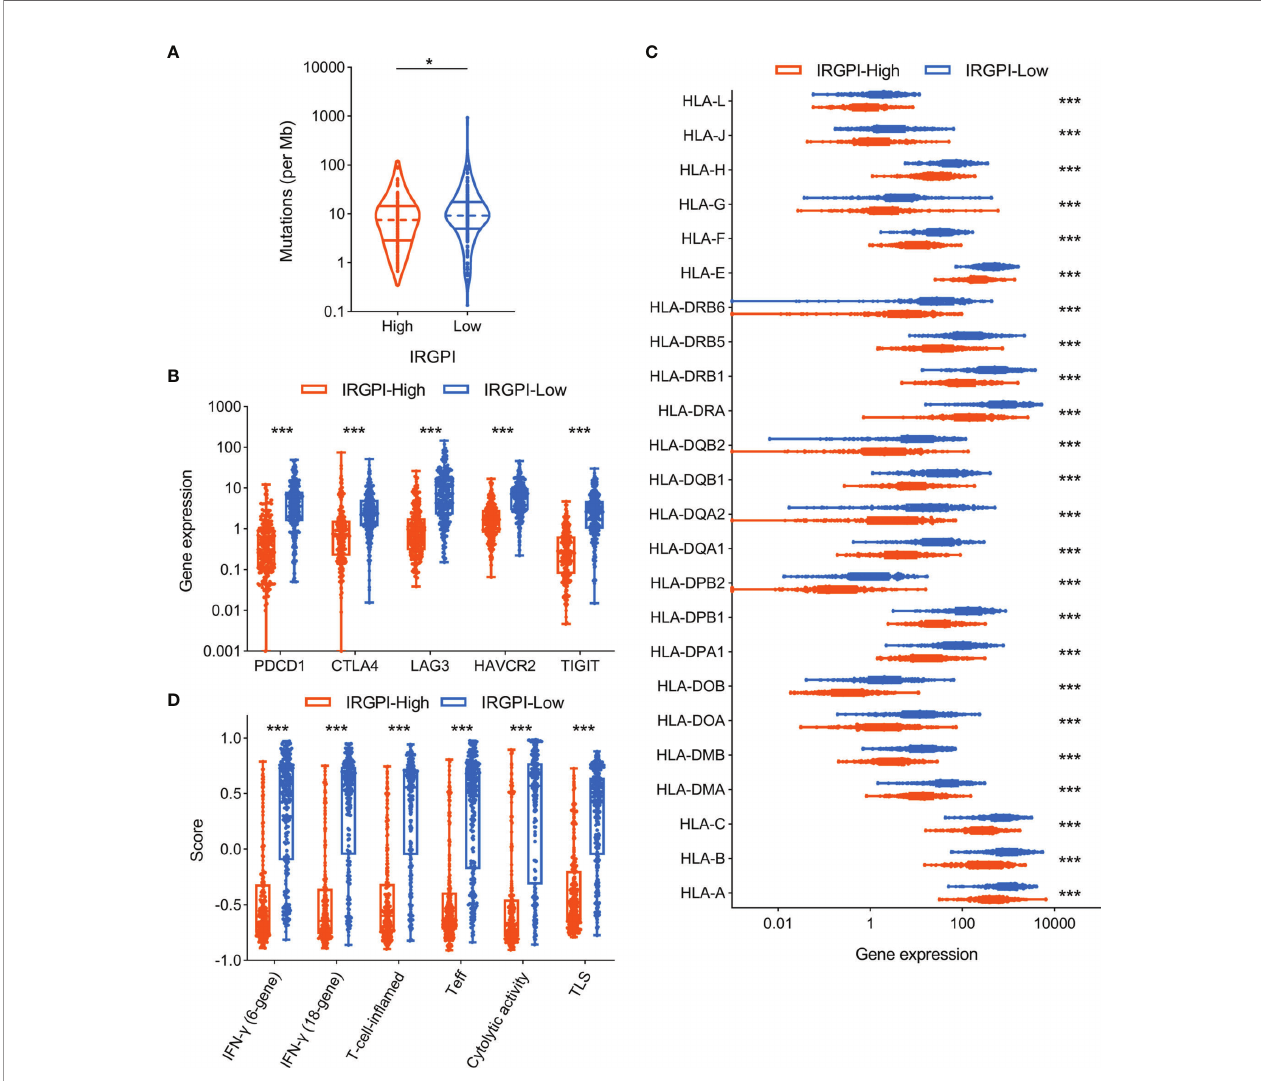
FIGURE 5 | Association of IRGPI to other potential biomarkers in melanoma. (A) Comparison of tumor mutation burden level according to IRGPI status. (B) Correlation of IRGPI to immune inhibitory receptors, including PDCD1, CTLA4, LAG3, HAVCR2, TIGIT. (C) The pro fi le of HLA member expression levels between IRGPI-high and IRGPI-low groups. (D) Box plot of the immune-related signatures in comparison of the IRGPI-high and IRGPI-low groups. IRGPI, immune-related gene pair index; HLA, human leukocyte antigen; IFN, interferon; Teff, effective T cells; TLS, tertiary lymphoid structure. * P < 0.05, *** P <